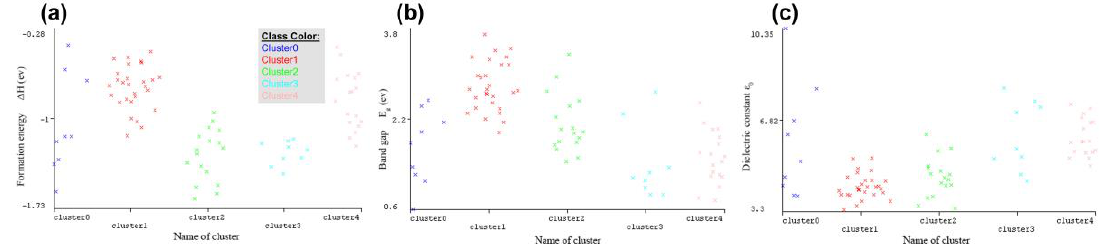
Figure 4. Clustering following the physical property obtained in WEKA. ( a ) Formation Energy; ( b ) Band gap; ( c ) Dielectric constant.